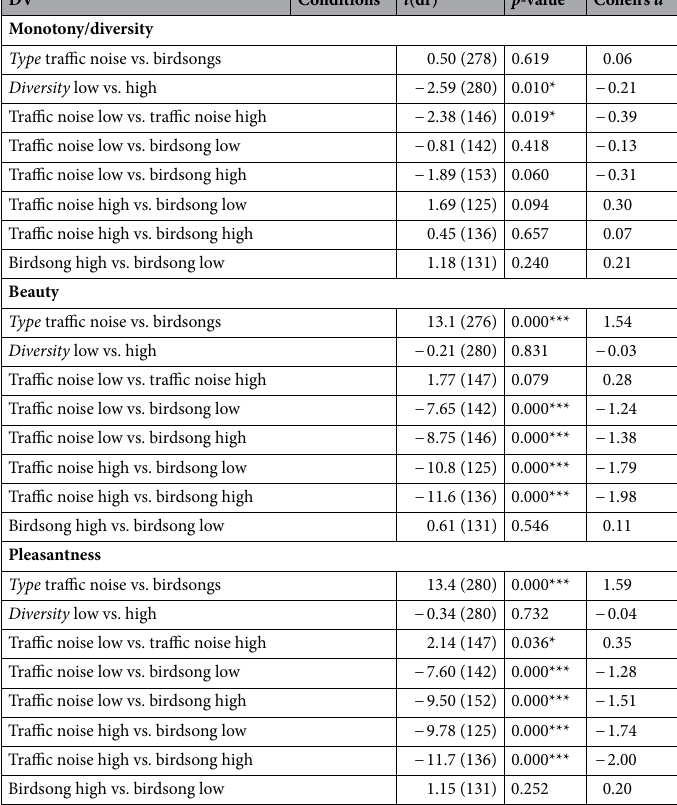
Table 1. Comparison of soundscapes concerning beauty, pleasantness, and diversity/monotony ratings in the total sample. * p < .05; *** p <